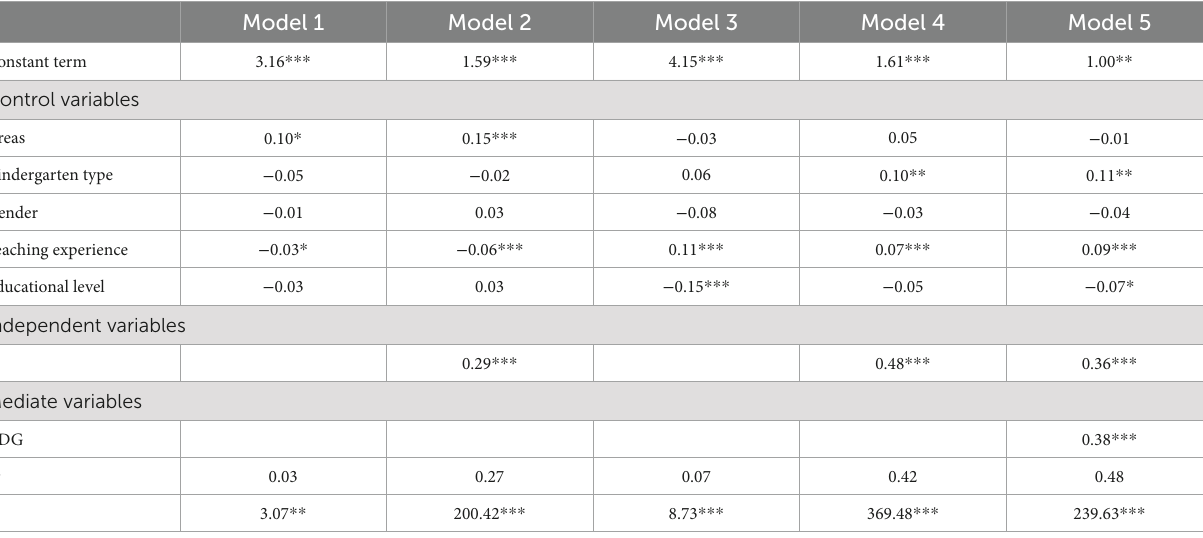
TABLE 3 Regression analysis of the relationship among